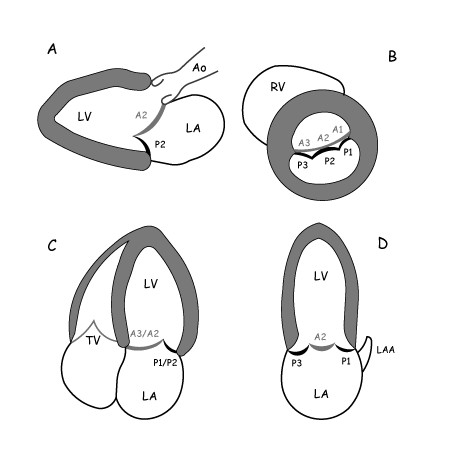
Standardized 2D-TTE imaging planes to assess the precise localization of prolapsing or flailing segments. (A) Parasternal long-axis view. (B) Parasternal short-axis view. (C) Apical four-chamber view. (D) Apical two-chamber view (intercommissural plane). Ao = ascending aorta; LA = left atrium; LV = left ventricle; LAA = left atrial appendage; RV = right ventricle; TV = tricuspid valve.